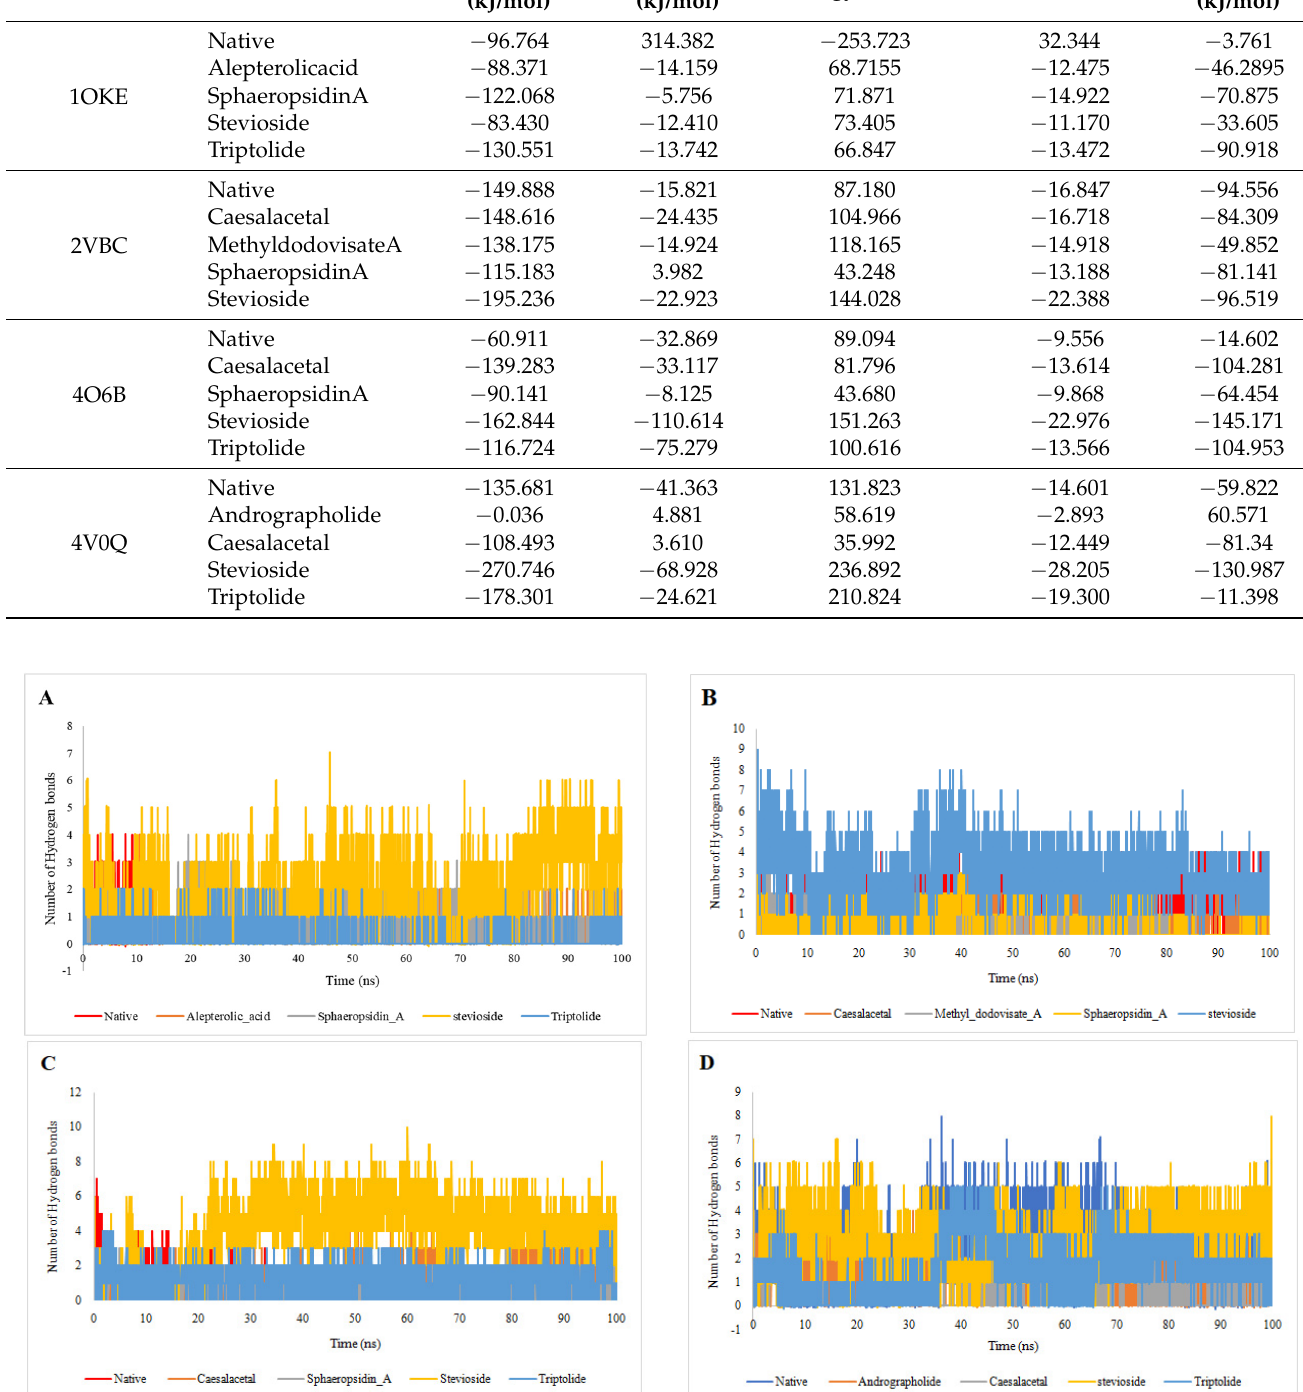
Figure 10. The hydrogen bonds plot between selected compounds with ( A ) 1OKE; ( B ) 2VBC; ( C ) 4O6B, and ( D )